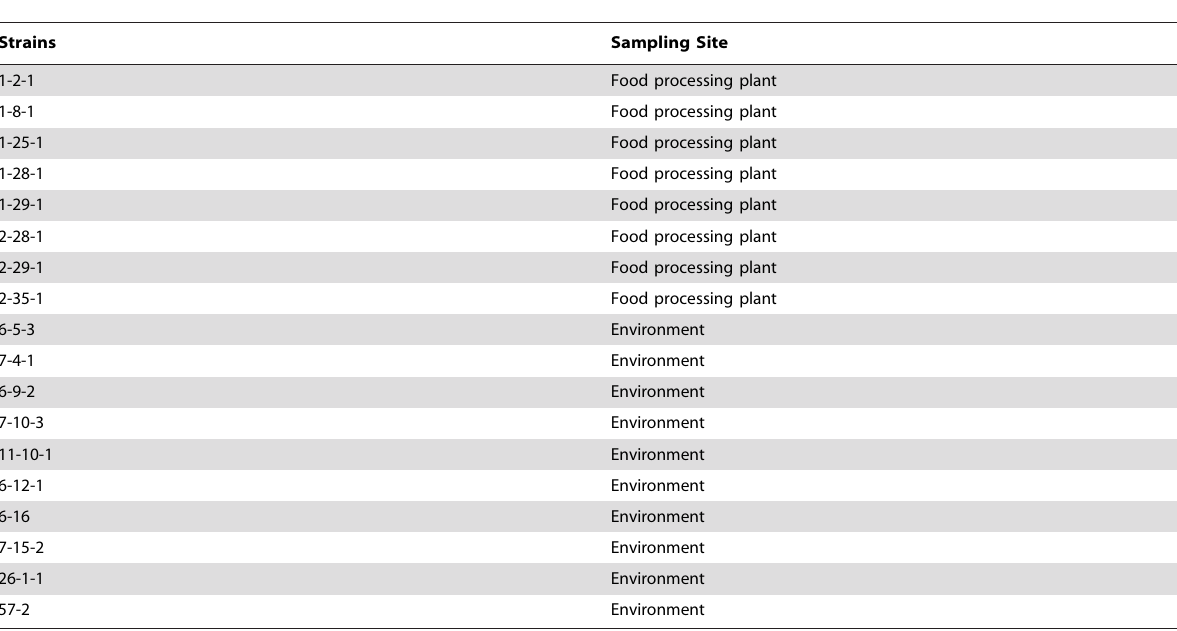
Table 1. Characteristics of L. innocua isolates used for development of the MLVA method.